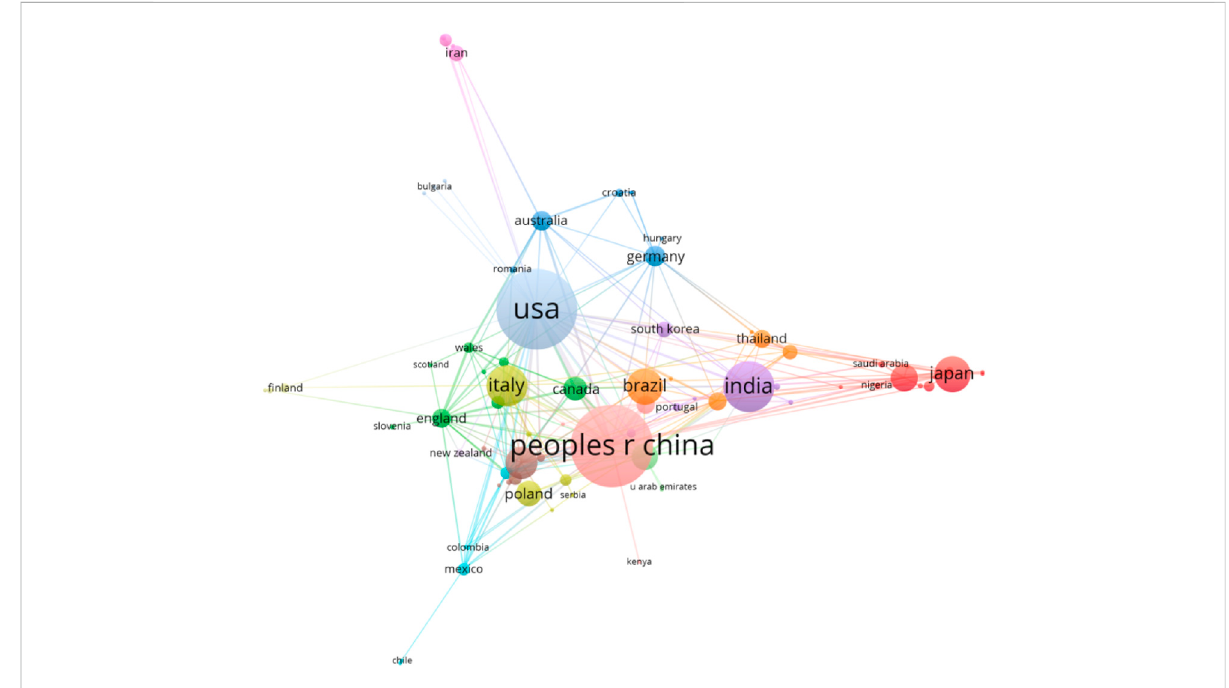
FIGURE 2 Knowledge map of cooperation between countr (freqiesuency ≥